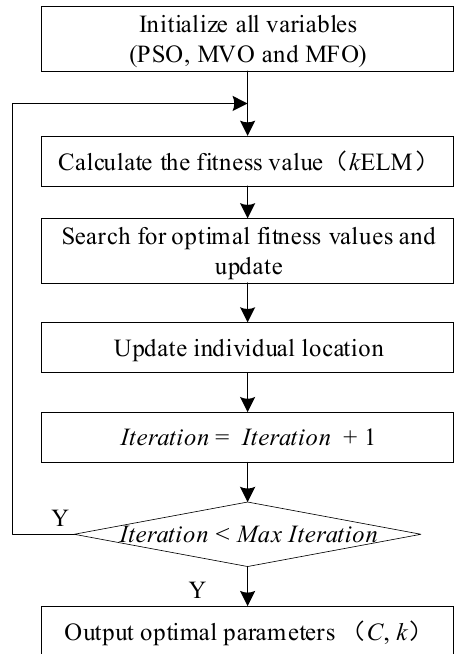
Figure 1. Algorithm steps to optimize the kernel extreme learning machine (kELM) prediction model. Table 2. The pseudocode of multiverse optimizer (MVO), particle swarm optimization (PSO), and moth–flame optimization (MFO) to optimize the parameters of kELM.